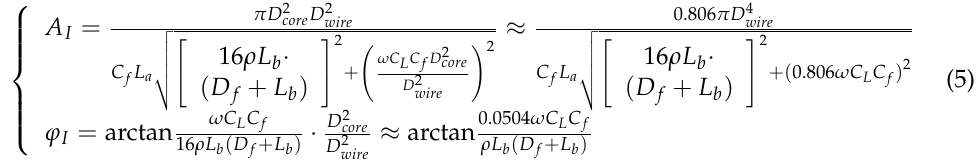
Figure 5. Curves of the static resistance and static inductance vs. the enameled wire diameter.